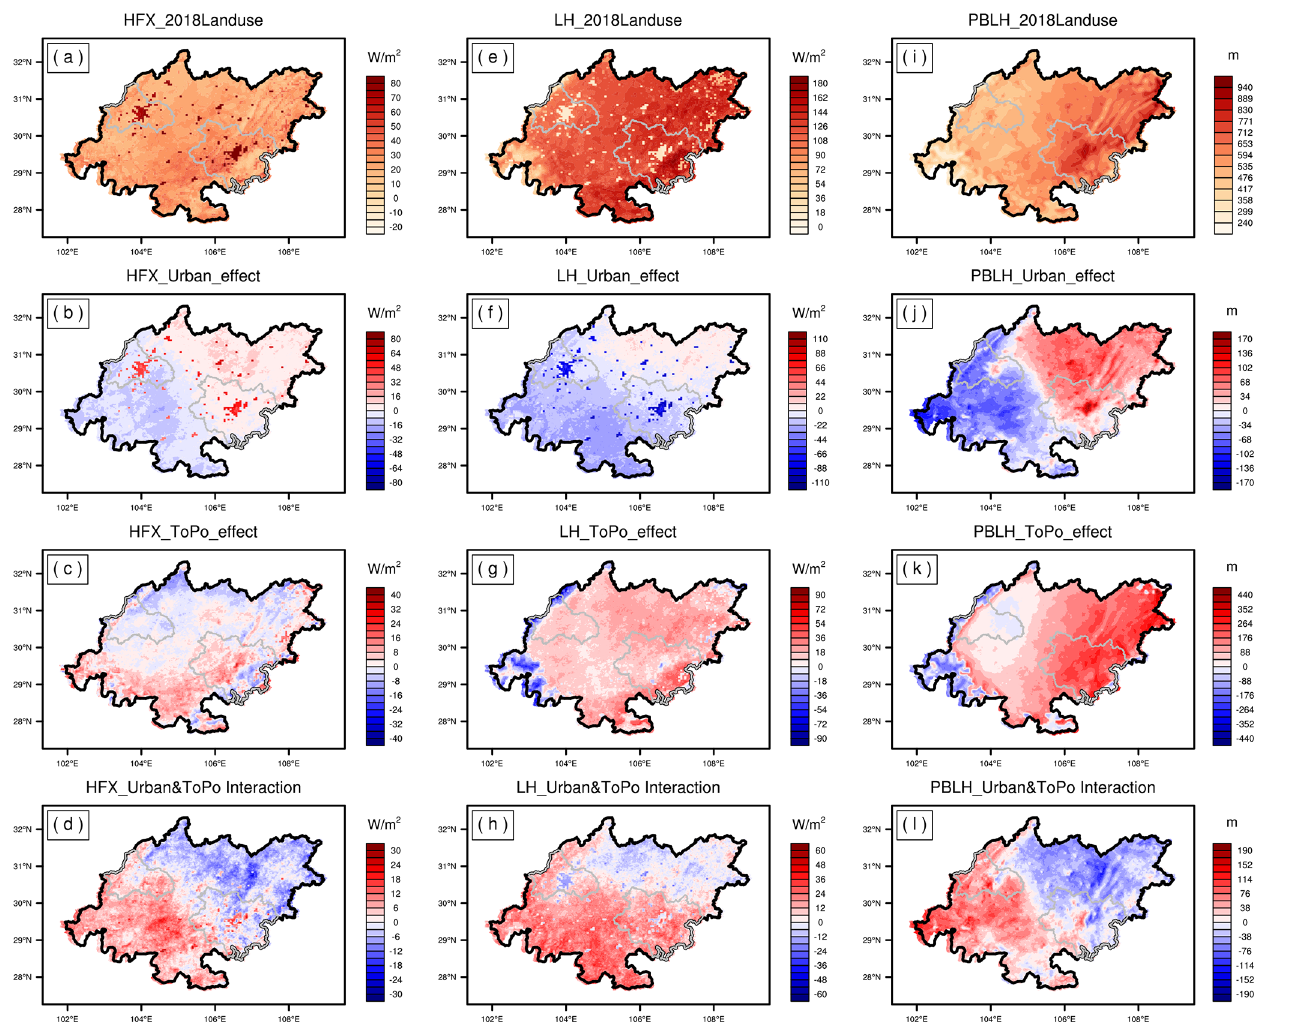
Figure 7. Influence of urbanization on urban heat flux and PBLH: (a) 2018 land use HFX; (b) influence of urbanization on urban effect HFX; (c) influence of urbanization on urban topography effect HFX; (d) influence of urbanization on the urban and topography interaction effect HFX; (e–h) influence of urbanization on urban LH; (i–l) influence of urbanization on urban